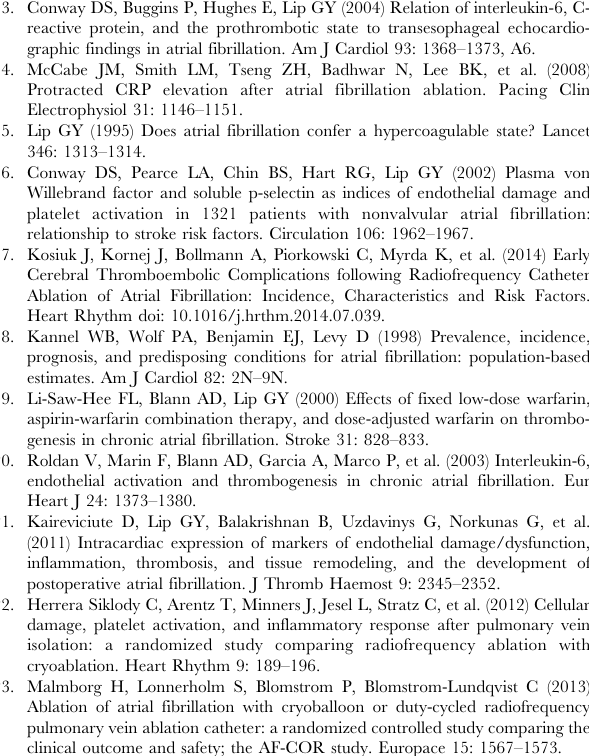
S3. Figure S1: Effects of catheter ablation on sP-sel levels. A: Peripheral circulation. B: Cardiac circulation. Figure S2: Effect of catheter ablation on hsIL-6 levels. A: Peripheral circulation. B: Cardiac circulation. Figure S3: Effect of catheter ablation on vWF levels. A: Peripheral circulation. B: Cardiac circulation. Methods: Radiofrequency catheter ablation. Table S1: Effects of